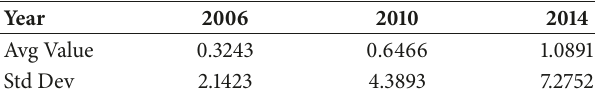
Table 1: Density of the HRB urban network.